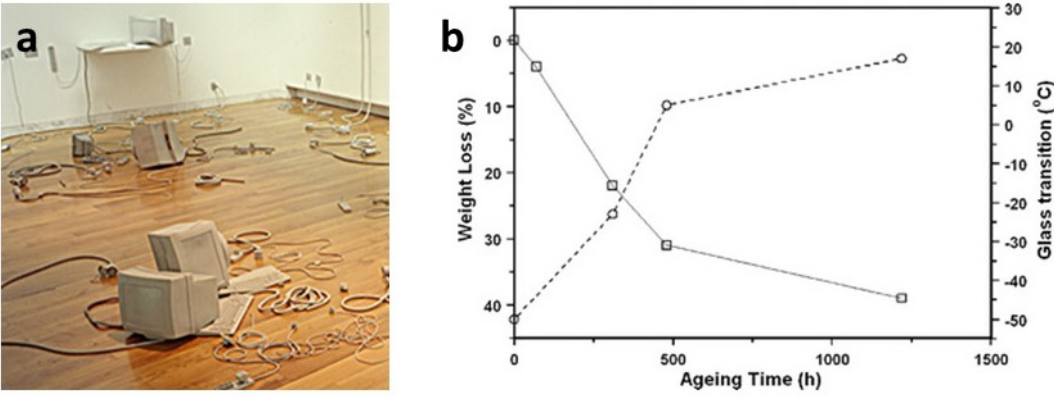
Figure 5. Partial view of “Stage Evidence” (1999) by L. Cecchini ( a ) and weight loss (solid line) and glass-transition temperature (dashed line) of the poly(ether urethane) used in the artwork as a function of the isothermal treatment duration at 120 °C ( b ). Image reprinted with permission from [30].